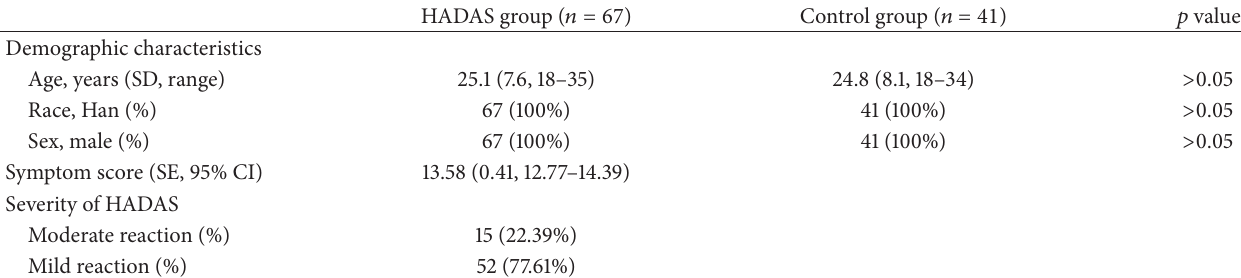
Table 1: Baseline characteristics of subjects at randomization according to the study